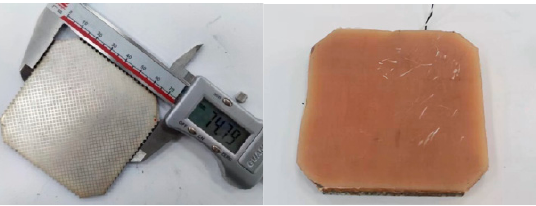
Figure 14. Narrowband ( Left ) And Broadband ( Right ) Octagonal Emission Arrays.